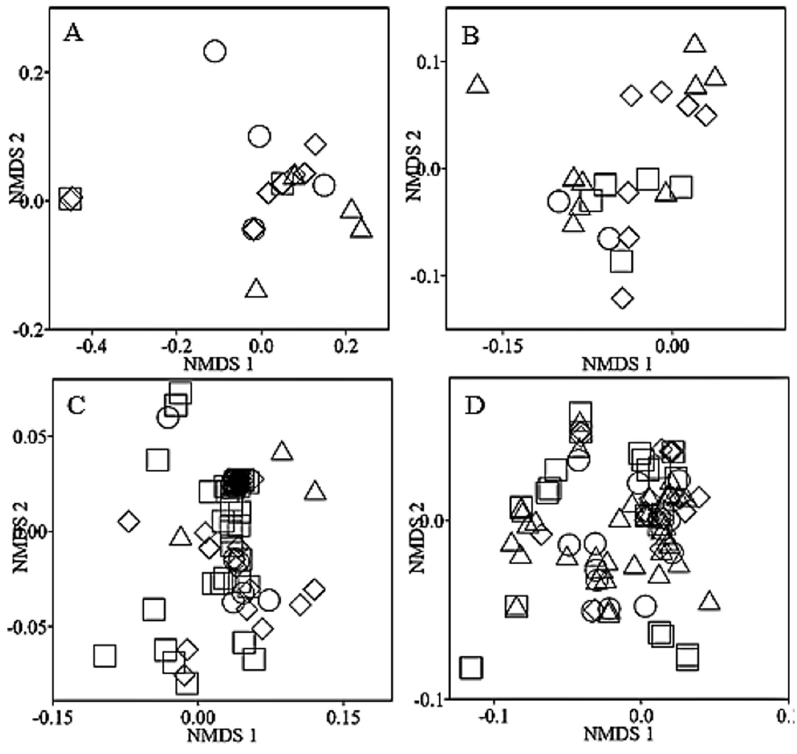
Figure 3. Graphical representation of the NMDS, showing the variation in the consumption of trophic guilds food resources present in the Umari reservoir, Rio Grande do Norte, Brazil. Guilds: Insectivorous (A); Carcinophagous (B); Malacophagous (C); Detritivorous (D), February ○ ; May  ; August  ; November  . Acta Limnologica Brasiliensia, 2018, vol. 30, e104